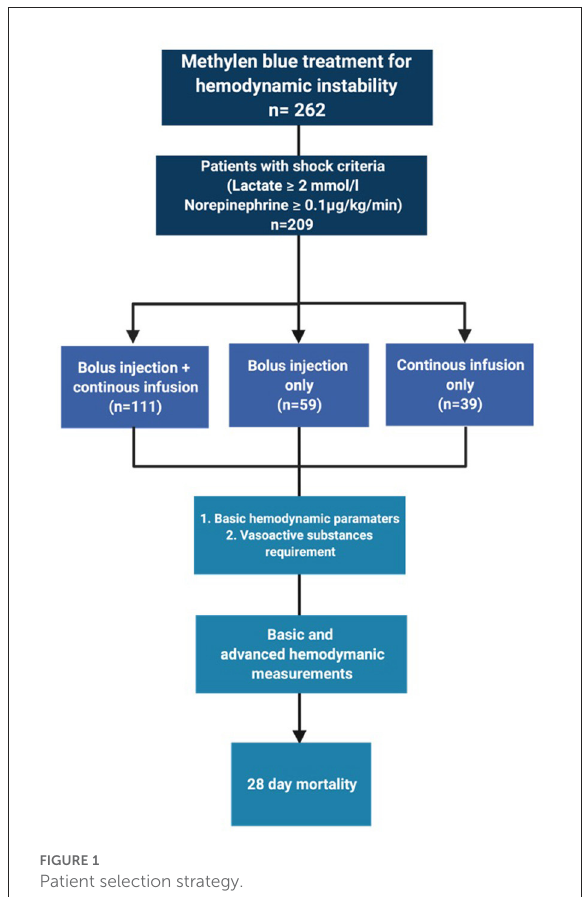
FIGURE1 Patient selection